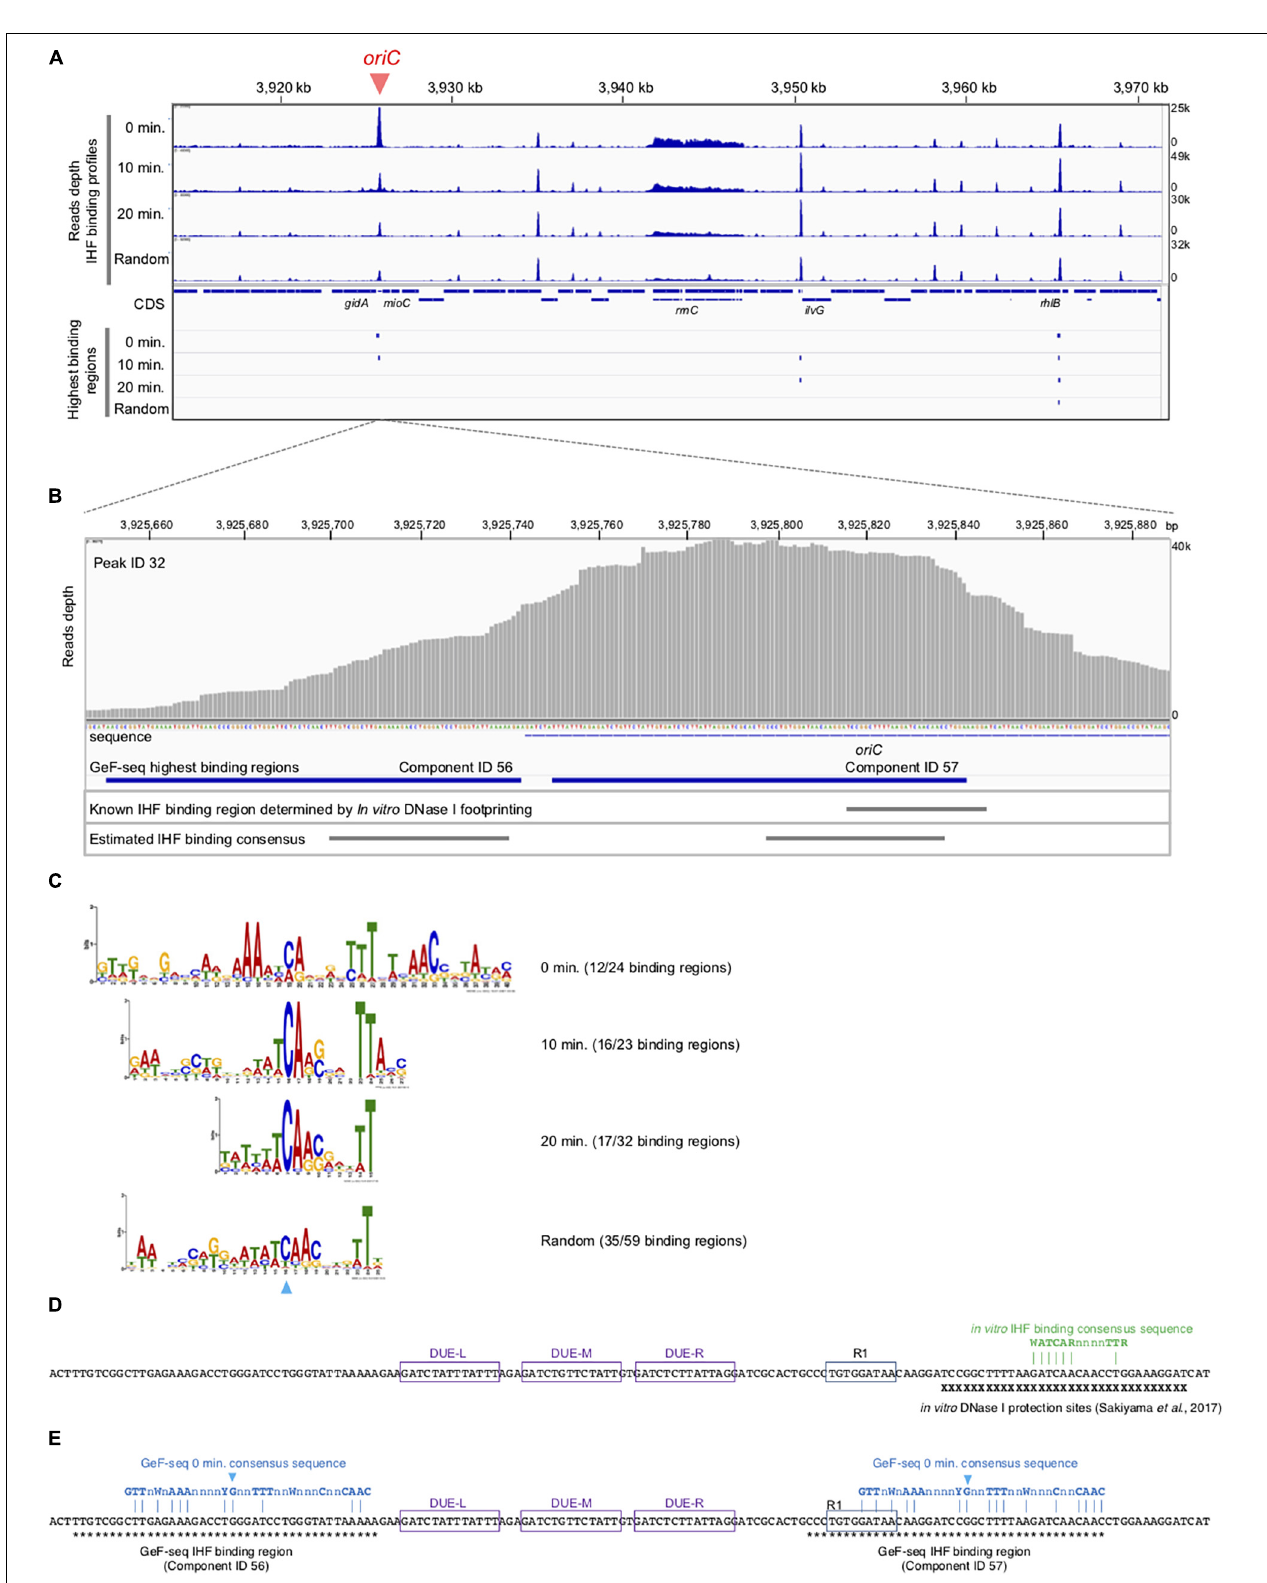
FIGURE 3 | Cell cycle-specific IHF binding at oriC in GeF-seq. (A) The IHF-binding profile in the region including 3,920–3,970 kb part in the E. coli K-12 genome.